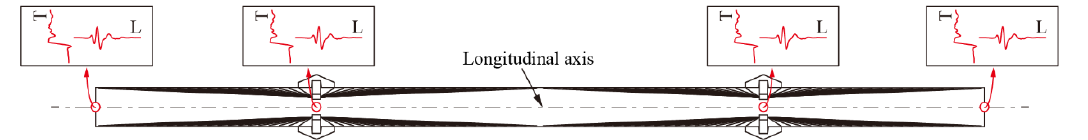
Figure 13. Input ground motions for near-fault cable-stayed bridges.